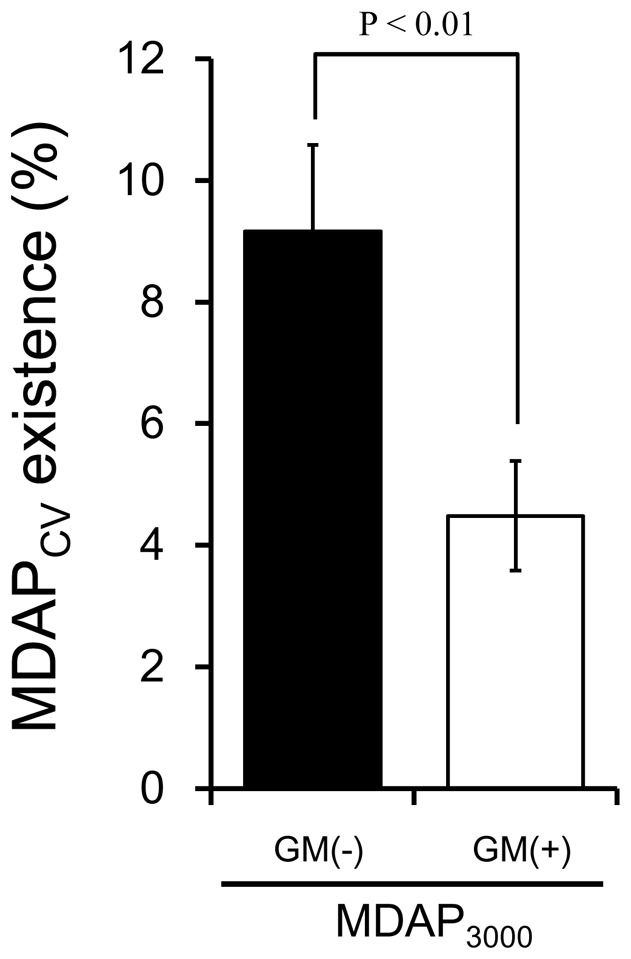
MDAPCV (%) present in tumors after intratumoral injection of MDAP3000 with or without MMP inhibitor (GM6001).